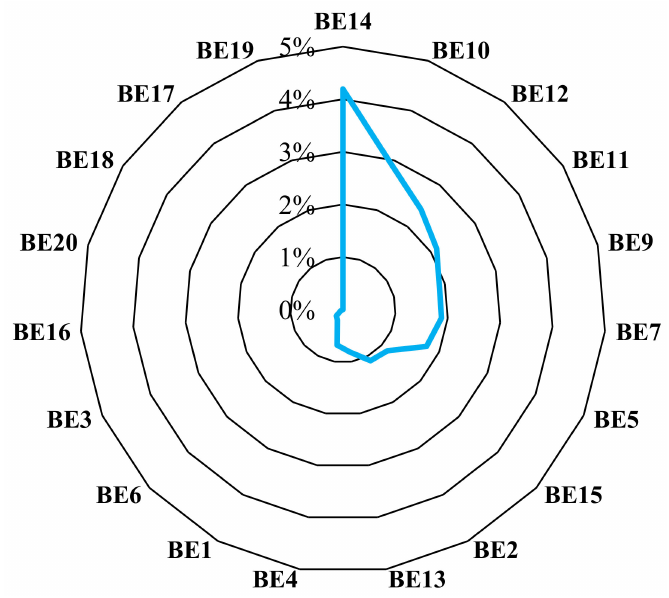
Figure 6. Percentage of risk